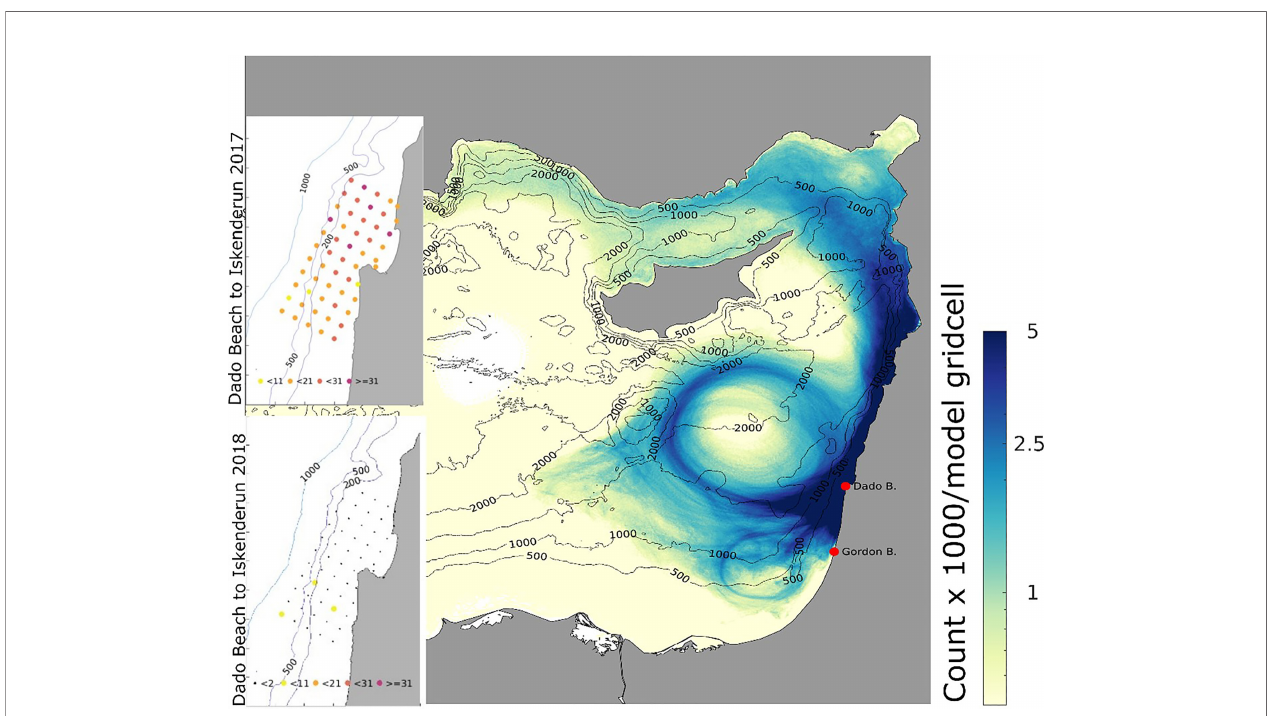
FIGURE 8 | Total number of particle visits within each model gridpoint, released from Dado beach (Haifa) from April 18 th to August 31 st of 2018. Insets: colour- coded release points off the coast of Haifa according to particle hit distribution on target beaches in 2017 (upper, left) and 2018 (lower, left), averaged across both release depths of 8m and 15m. Inset numbers refer to hits at Iskenderum from the release points, so the red points are connected to the target beach with more than 31 particles (2017) and small black points less than two particles (2018).